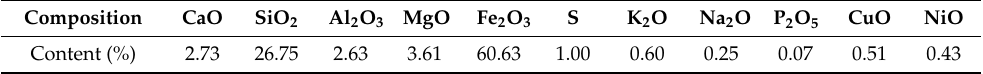
Table 1. Chemical composition of smelting slag of copper and nickel deposits